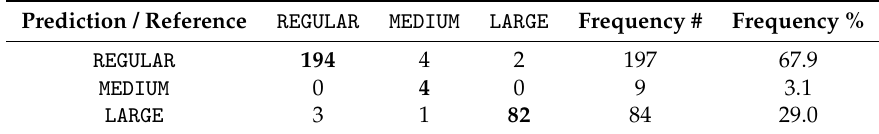
Table 8. Results on logo size detection on an unseen validation dataset, performed by the Adidas team. Overall accuracy is 96 . 6 % on 290 images. The numbers of correct predictions per class (on the main diagonal of the matrix) are highlighted in boldface